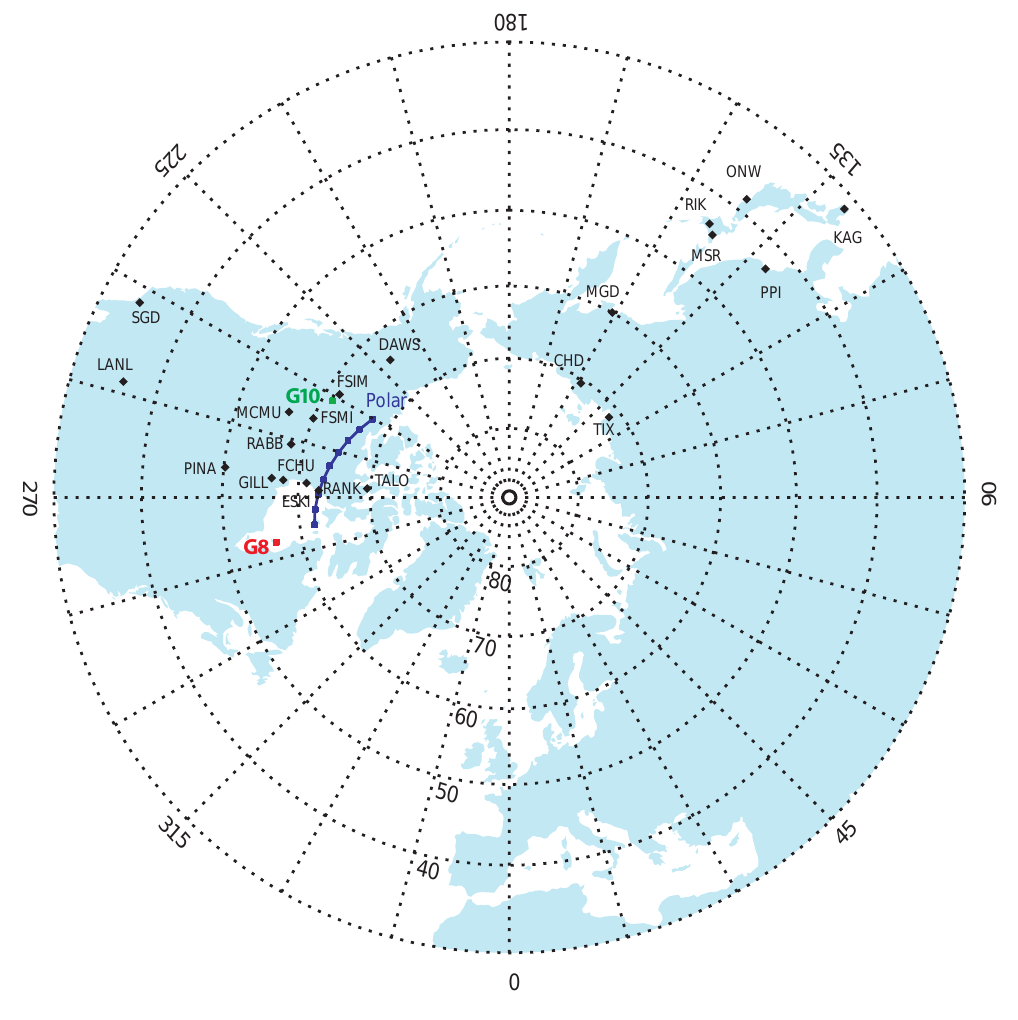
Fig. 8. Geographical locations of the ground stations (solid squares) and spacecraft footprints (dots). In the North American sector, the ground stations include 11 CANOPUS stations at high latitudes and two from the UCLA magnetometer array at mid-latitudes. The green and red crosses are the footprints of GOES 10 and 8 spacecraft, respectively. The connected blue dots are the 4-h ground track of the Polar spacecraft from 20:00 to 24:00 UT, moving westward and marked every 30min. In the Asian/Pacific sector, 8 ground stations from the 210MM array are